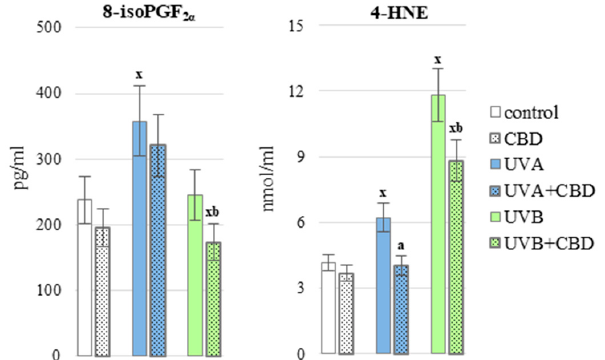
Figure 7. The level of 8-isoPGF 2 α and 4-HNE in the blood plasma of nude rats in the following groups: control; treated with CBD (every 12 h) for 4 weeks; irradiated with UVA (every 48 h) for 4 weeks; irradiated with UVA (every 48 h) and treated with CBD (every 12 h) for 4 weeks; irradiated with UVB (every 48 h) for 4 weeks; irradiated with UVB (every 48 h) and treated with CBD (every 12 h) for 4 weeks. The mean values for six rats in each group ± SD are shown: x—differences vs. control group, p < 0.05; a—differences vs. UVA treated group, p < 0.05; b—differences vs. UVB treated group, p < 0.05.